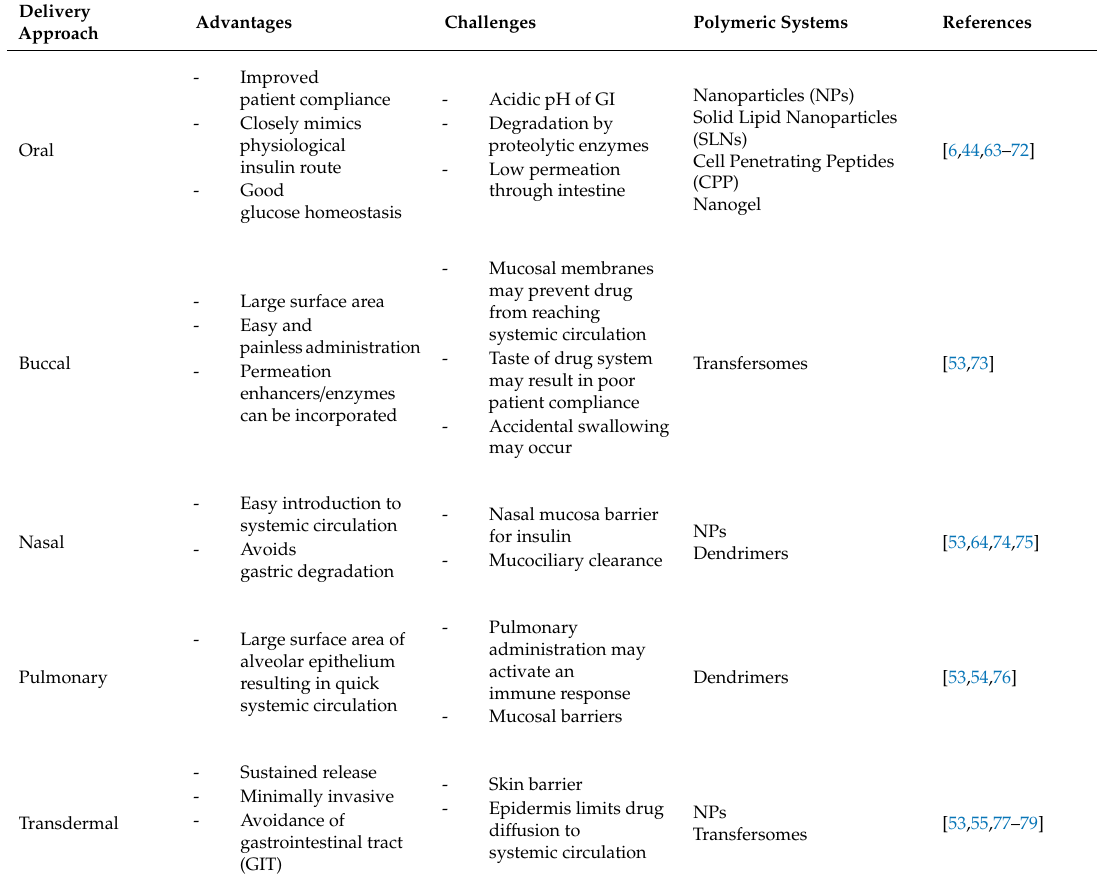
Table 2. Summary of advantages and challenges associated with polymeric nanoplatforms for various insulin delivery